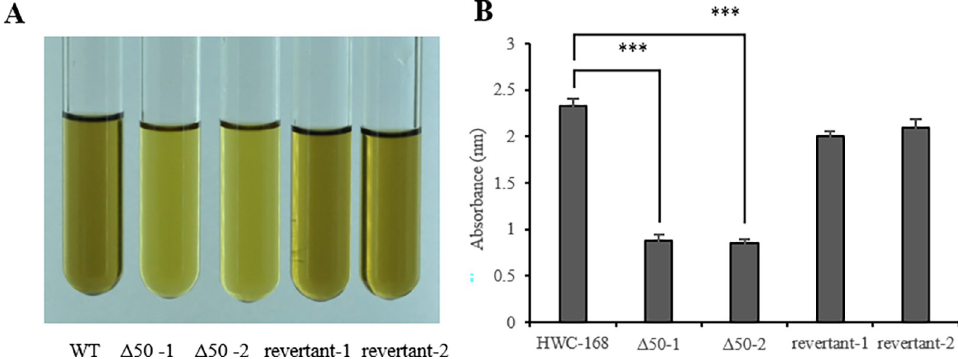
Fig 5. Determination of the phenotype and melanin of the wild-type, Δ 50 mutant and revertant strains. ( A ) the solution of wild-type, Δ 50 mutant and revertant strains that determine the melanin content. ( B ) the absorbance of the wild-type, Δ 50 mutant and revertant strain solutions at 400